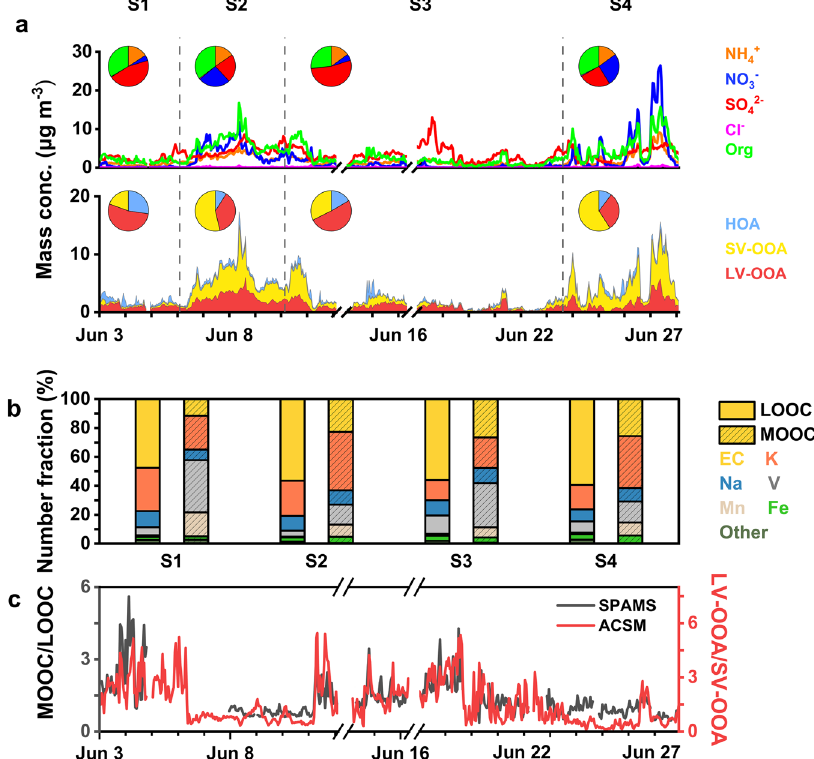
Fig. 1 Bulk and individual measurement results. a Time series of the NR-PM 1 and organic species concentrations at the four stages; b number fraction of the particle subgroups (EC, K, Na, V, Mn, Fe, and other subgroups) in the LOOC and MOOC particles at the four stages; c time series of the LV-OOA/SV-OOA values obtained with the ACSM instrument and MOOC/LOOC values obtained via